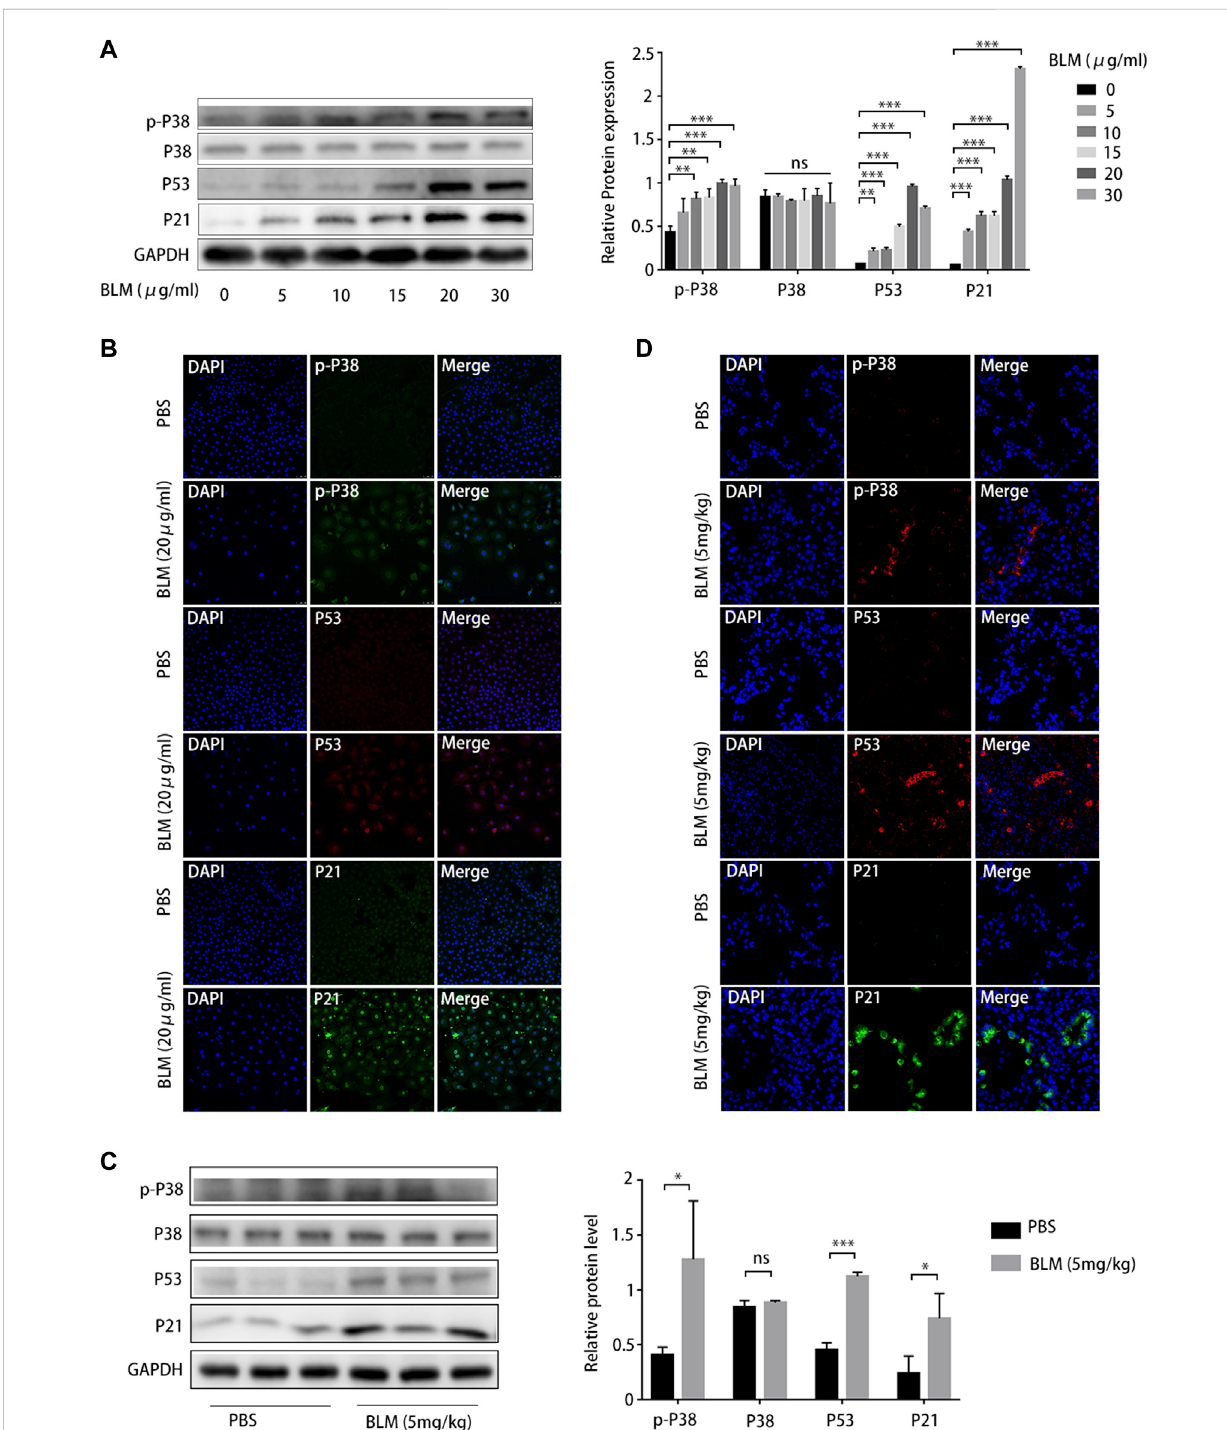
FIGURE 7 P38/P53/P21 pathway is activated in A549 senescent cells and bleomycin (BLM)-induced pulmonary fi brosis mouse model. (A) Western blot of p-p38, p53, and p21 levels in A549 cells treated with different BLM concentrations (0 – 30 μ g/mL). (B) Immuno fl uorescence staining of p-p38, p53, and p21 inA549 cells treated with phosphate-buffered saline (PBS) or BLM (20 μ g/mL). (C) Westernblotof p-p38, p53,and p21expressioninlungtissuefrom mouse models treated with PBS or BLM (5 mg/kg) for 21 d. (D) Immuno fl uorescence staining of p-p38, p53, and p21 in lung sections of a mouse model treated with PBS or BLM (5 mg/kg) for 21 d. * p < 0.05, ** p < 0.01, *** p < 0.001; ns: not statistically signi fi